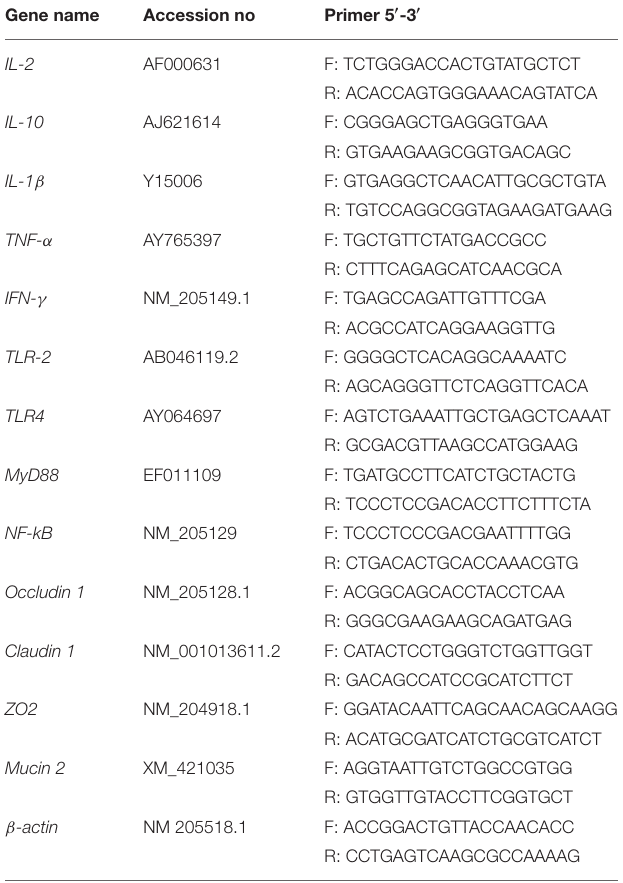
TABLE 2 | Primers used for quantitative polymerase chain reaction. TABLE 3 | The effects of EP supplementation on growth performance of broiler